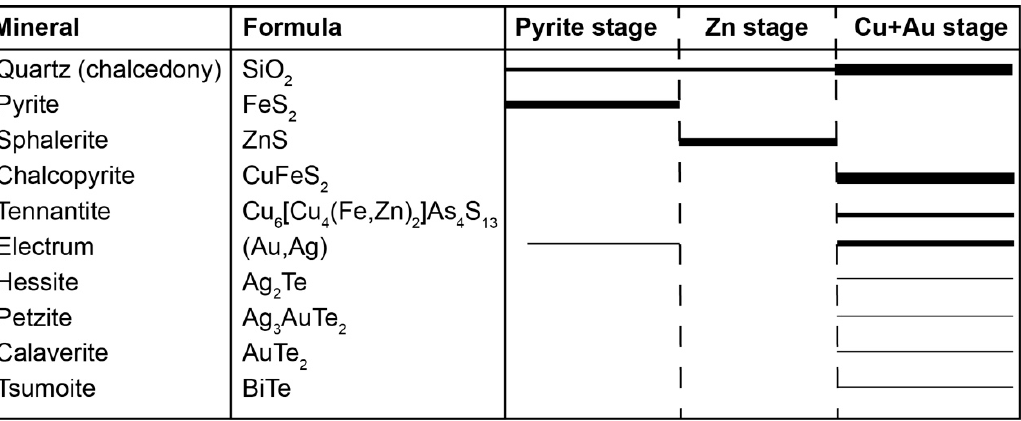
Figure 9. Thin section photomicrographs (reflected light: A – C ) and SEM images (EDS mode: D – I ) of electrum particles found in the Romero deposit lining vuggs in chalcopyrite ( A , B , D – F ), pyrite ( C , D , H , I ), and sphalerite ( G ) and in the gangue matrix ( C ). Abbreviations: clv = calaverite; cpy = chalcopyrite; el = electrum; sl = sphalerite; ptz = petzite; py = pyrite; tsu = tsumoite.